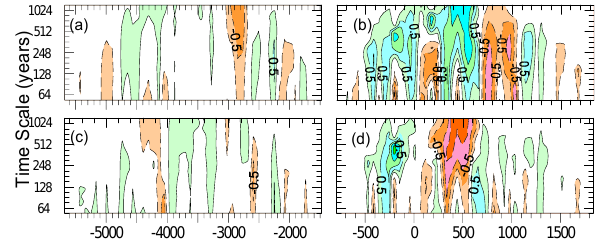
Fig. 6. (a–b) as same as in Figs. 5a–b but for the δ 18 O series; (c–d) as same as in Figs. 5e–f but for coherency between the δ 18 O and the precipitation reconstruction